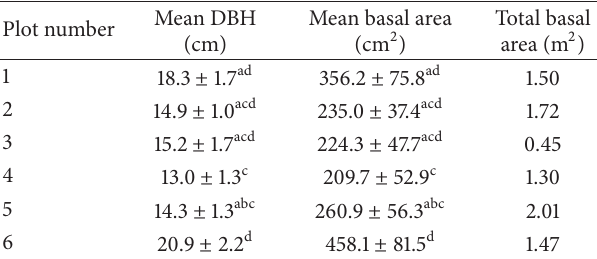
Table 3: Mean diameter at breast height (DBH), mean basal area, and total basal area of trees in six plots in the Tutong White Sands. Total basal area of a plot was calculated from the sum of basal areas of all trees within the plot. Different superscript letters indicate significant differences in plot mean values at 𝛼 = 0.05.